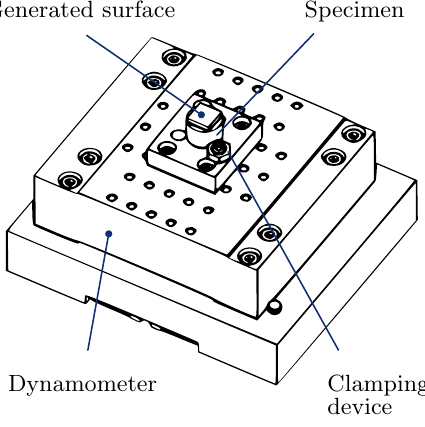
Figure 6. Experimental setup for milling of AMCs.